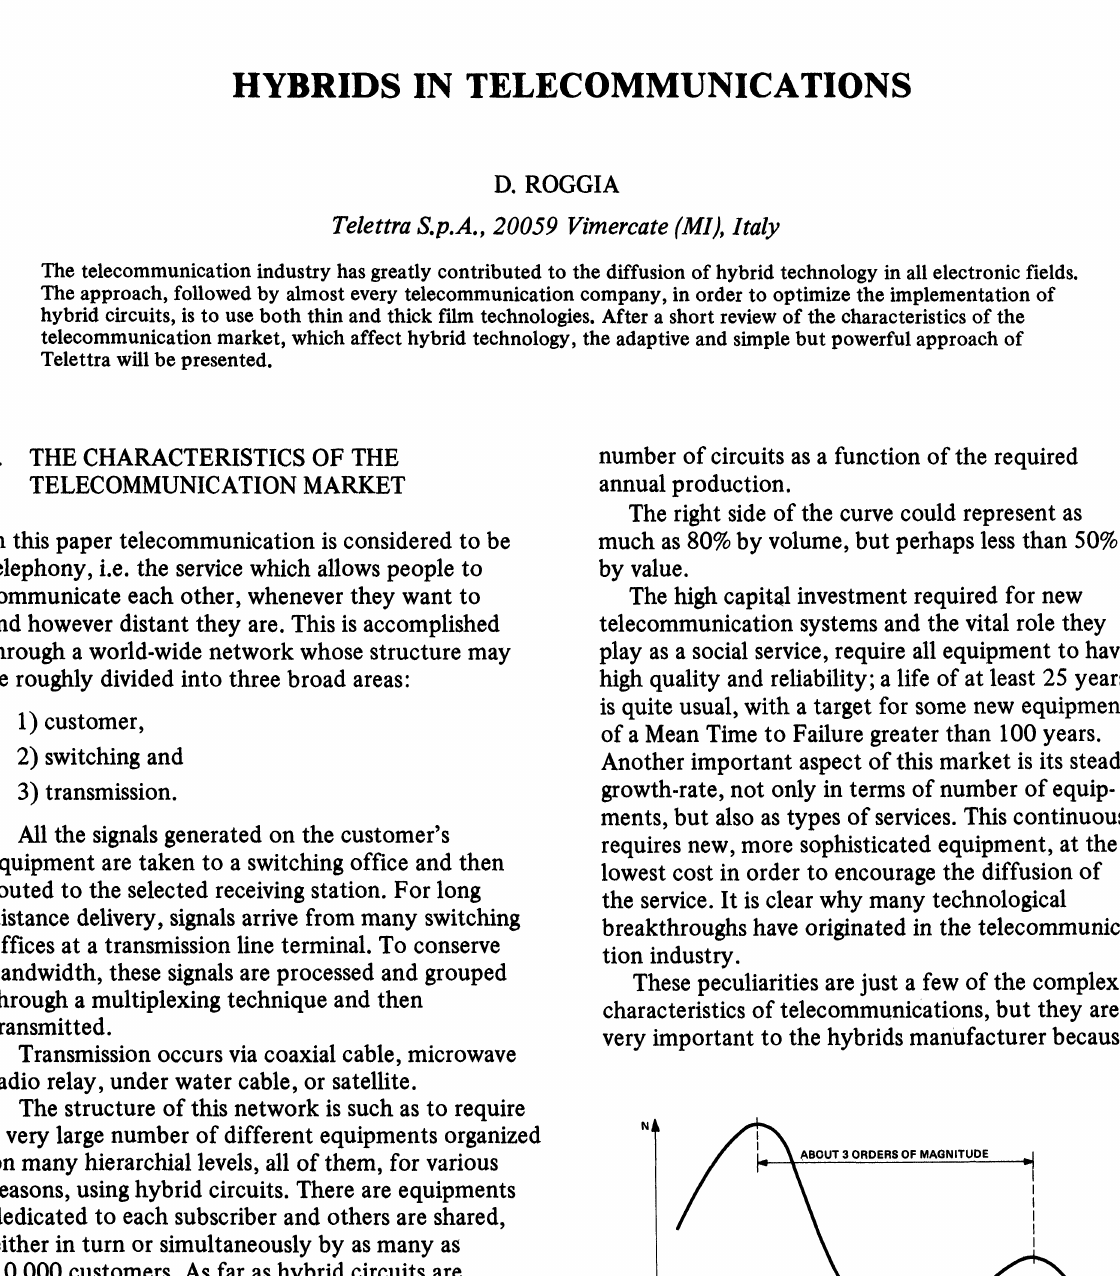
Products distribution; number of circuits, N, vs. the required annual production,